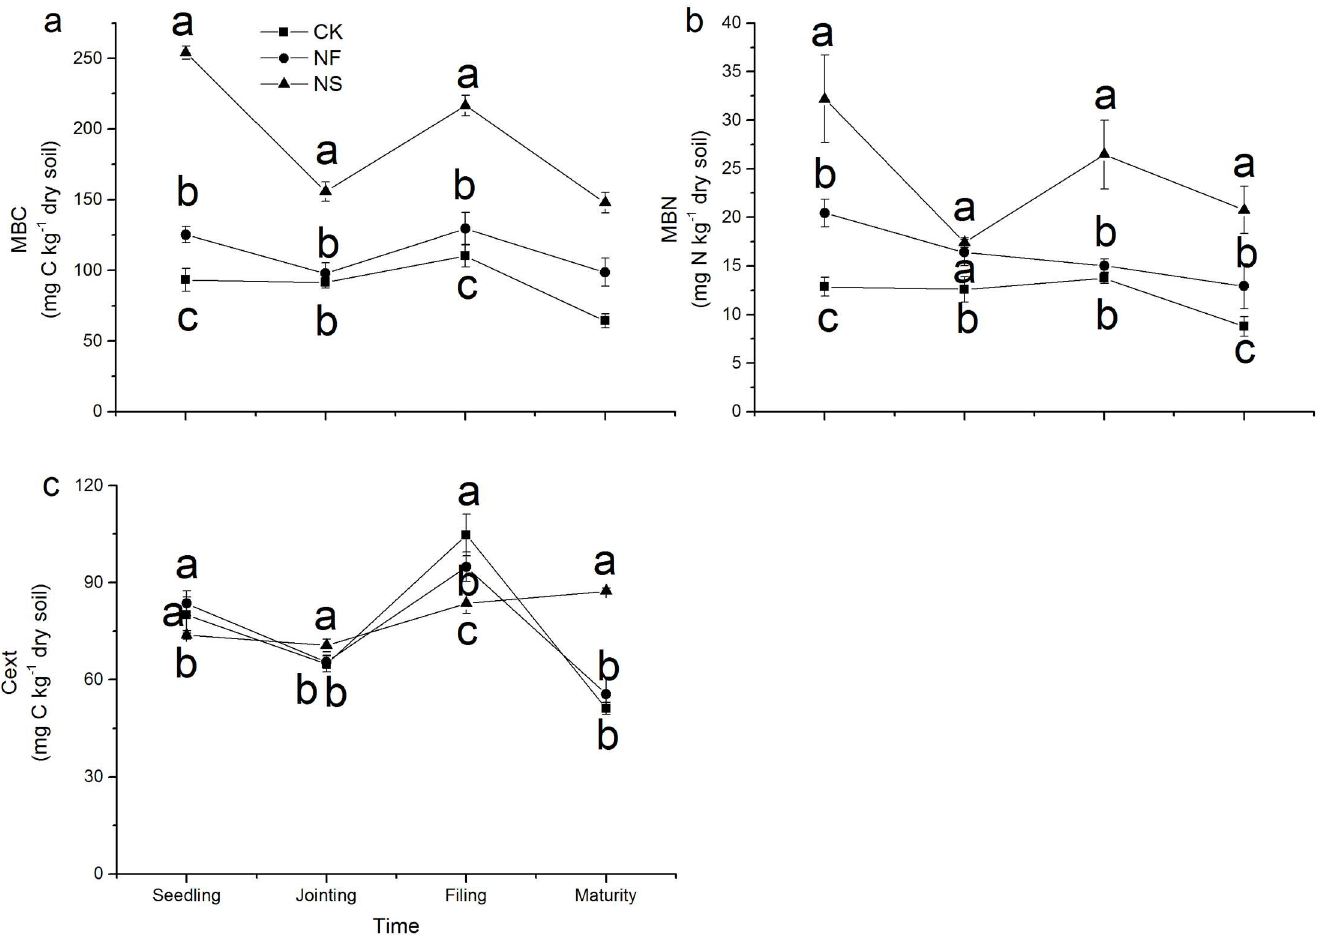
Fig 1. Changes in microbial biomass C (a), microbial biomass N (b), soil extractableC (c) in different treatments. Data points represent the mean of four replicates and error bars are the standarddeviationof the mean. The three treatments are: CK, control; NF, (NH 4 ) 2 SO 4 ; NS, (NH 4 ) 2 SO 4 + rice straw. Different letters at each samplingdate indicatea significantdifference betweendifferent treatments at P < 0.05.